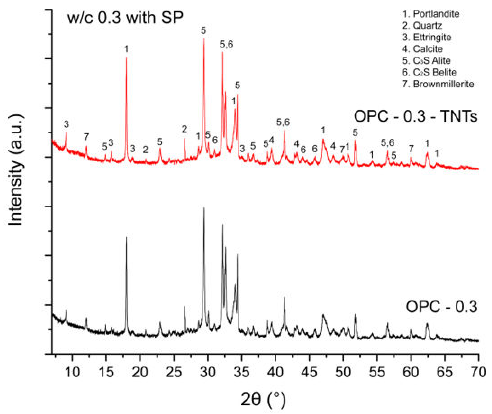
Figure 9. XRD patterns of OPC-0.3 and OPC-0.3-TNTs at 28 days of curing.